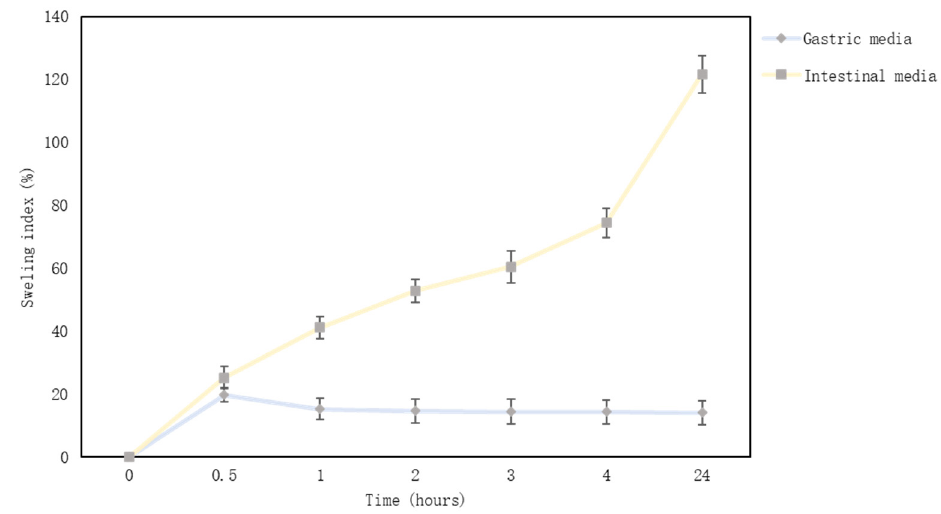
Figure 4. Microcapsules swelling graph in simulated intestinal and gastric media.